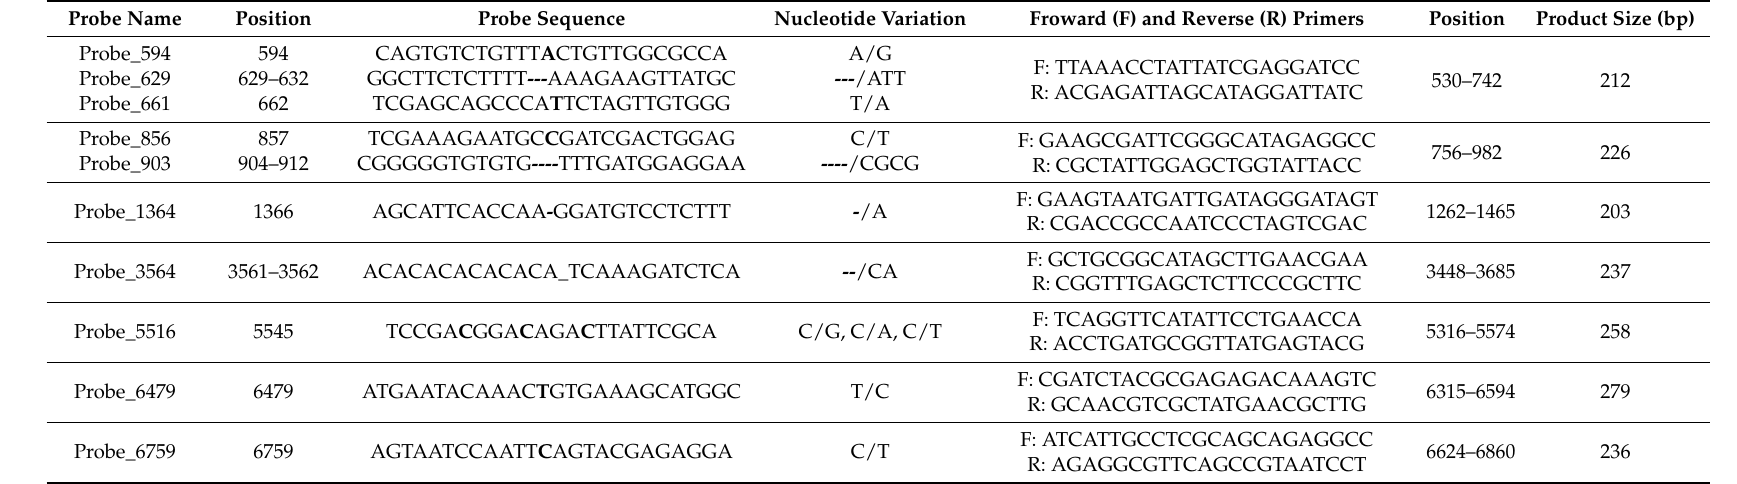
Table 3. Position and sequences of designed probes and primers used for high resolution melting to detect melting temperature variation between isolates after high resolution